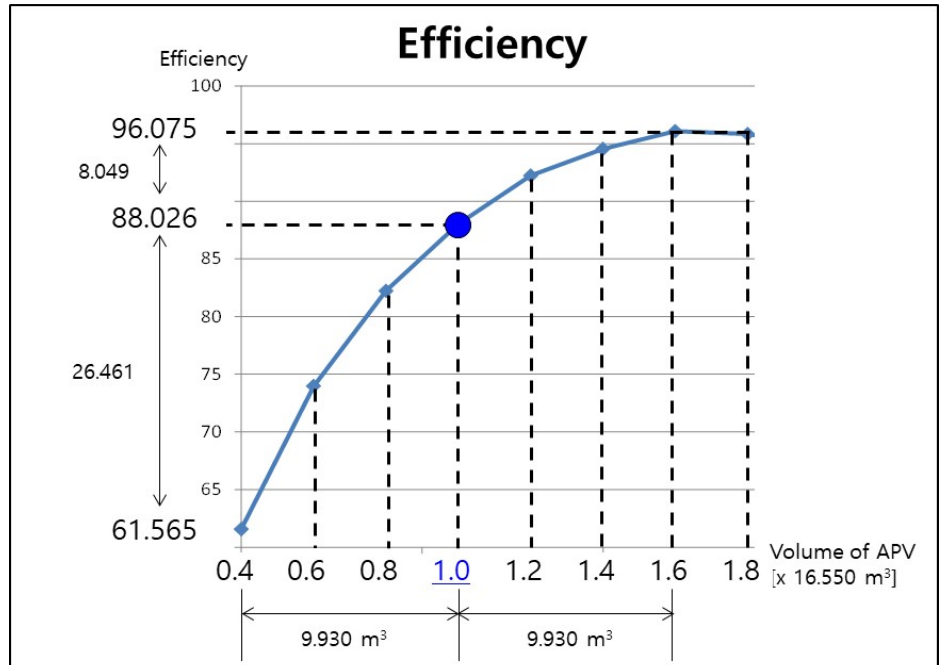
Figure 22. Configuration of the DSC simulation model.